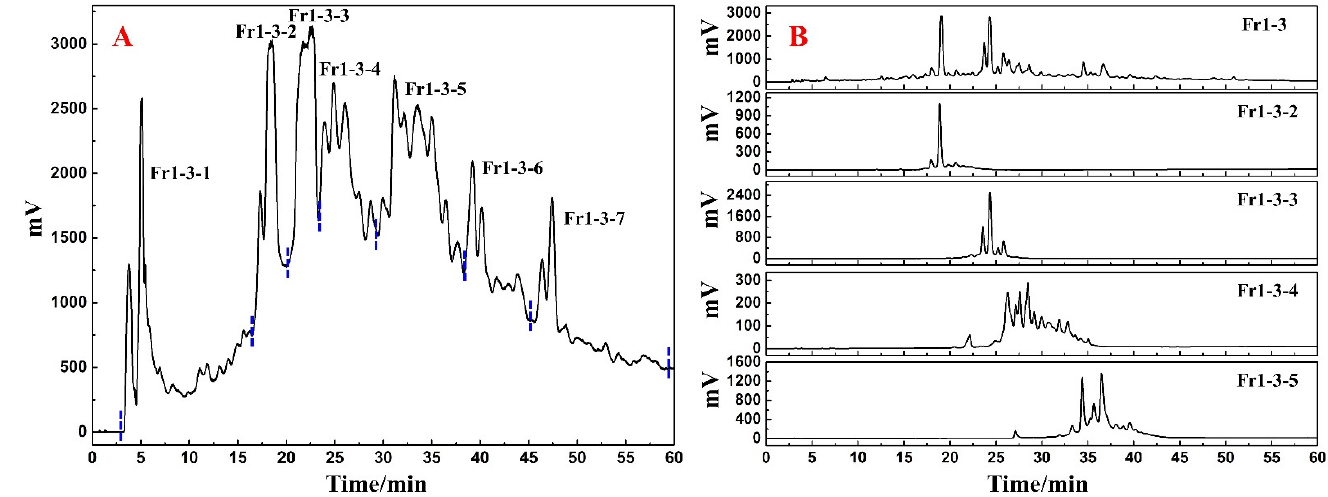
Figure 2. Preparation chromatograms ( A ) on the ReproSil-Pur C18 AQ preparative column of Fr1-3. Analytical comparison chromatograms ( B ) between fraction Fr1-3 and subfractions Fr1-3-2, Fr1-3-3, Fr1-3-4, and Fr1-3-5.